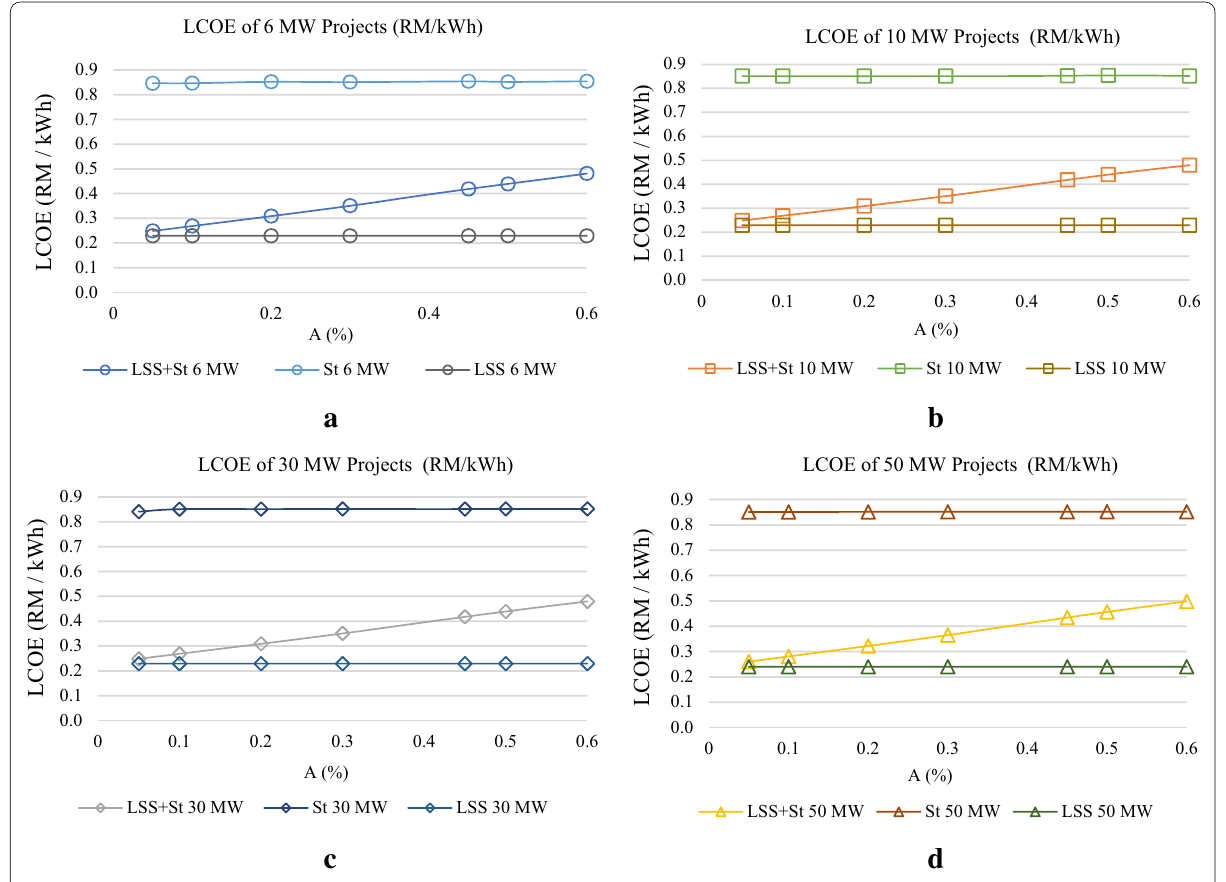
Fig. 8 Levelized cost of electricity of the different investment types for each LSS capacity. a 6-MW projects, b 10-MW projects, c 30-MW projects, d 50-MW projects